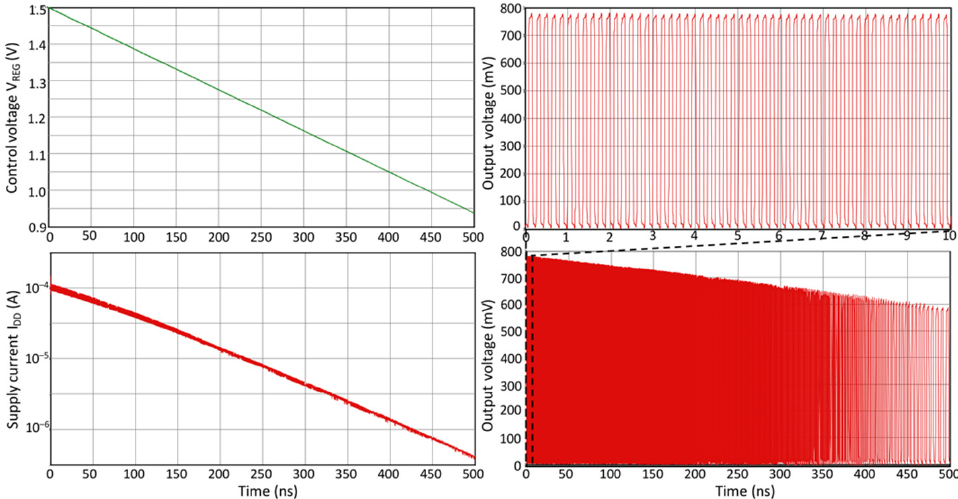
Figure 22. Simulated operation of five-stage CBip ring oscillator with supply voltage controlled by a NMOS transistor: control voltage, supply current (log scale) and output voltage as a function of time; V CC = 1.2 V, temperature 400 K.